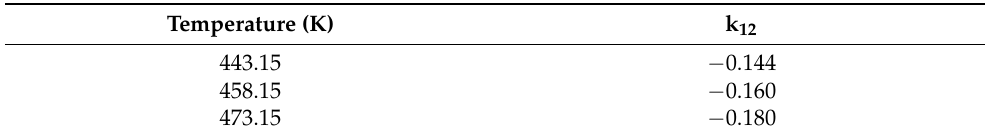
Table 6. Predicted binary interaction parameters for PS + CO 2 at different temperatures using Equation (9).